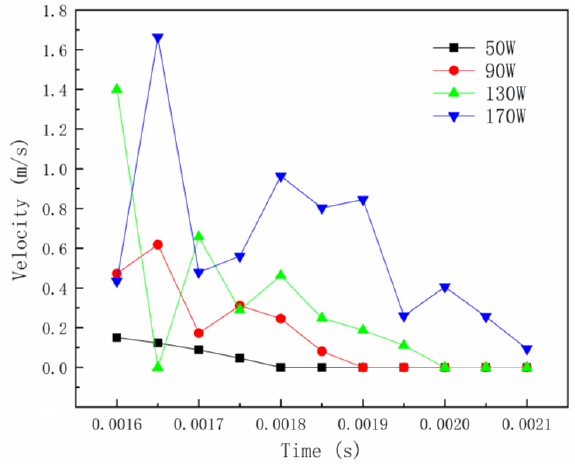
Figure 13. The flow velocity of the molten pool of the monitoring point fluctuates with time under different ILP power.